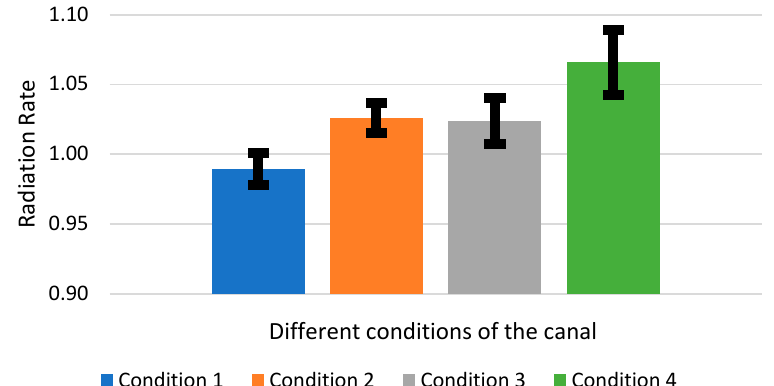
Figure 6. Overall average for each condition at 95% confidence interval.